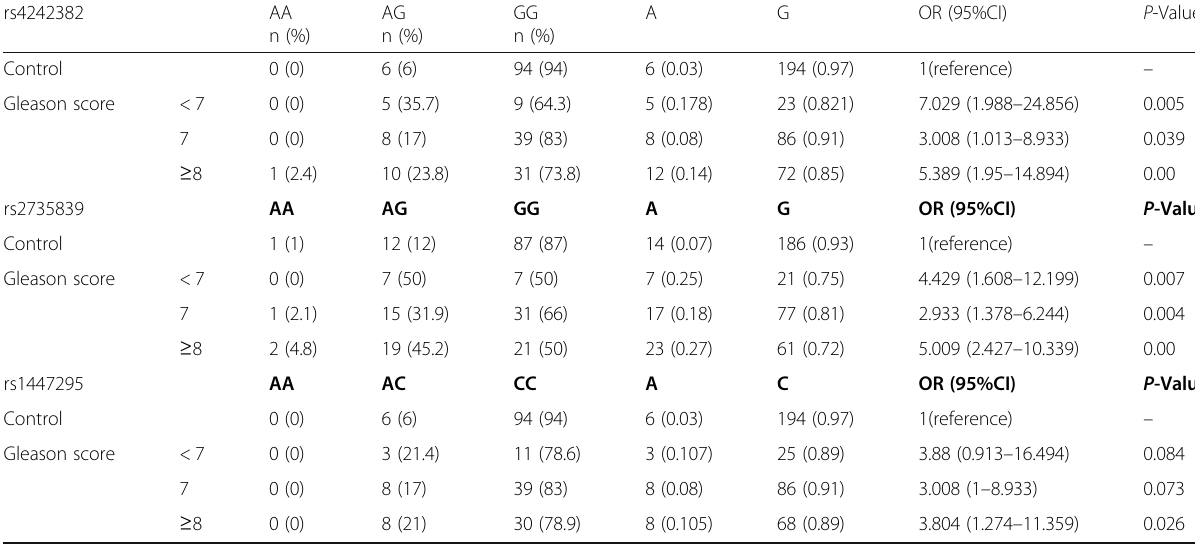
Table 6 Genotype and allelic frequency, the OR[95%CI] and P -value of risk allele compared to wild allele at three categories of Gleason score